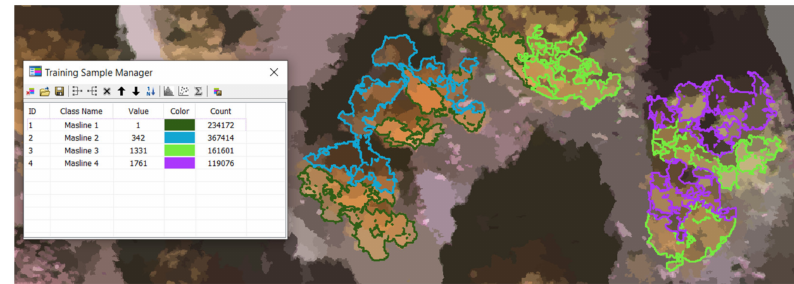
Figure 5. Adding olive tree class